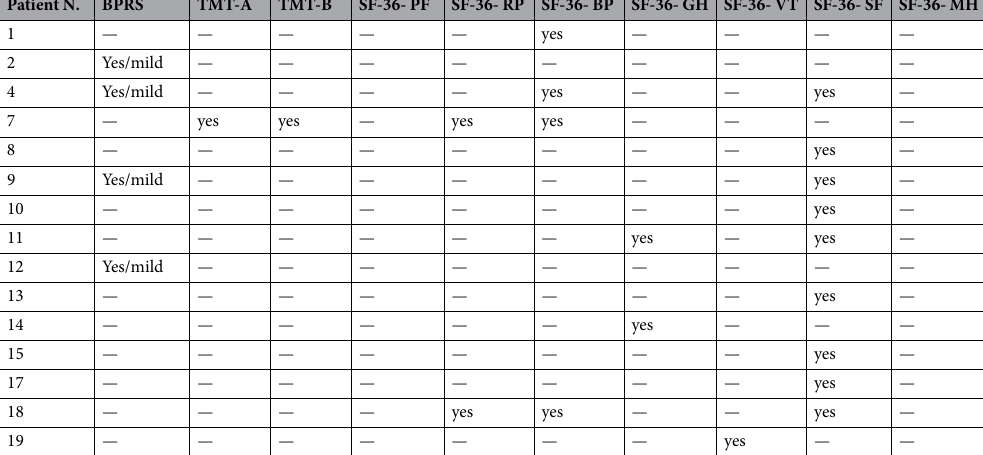
tionship was observed between MRI findings and neuro-psychiatric assessment.